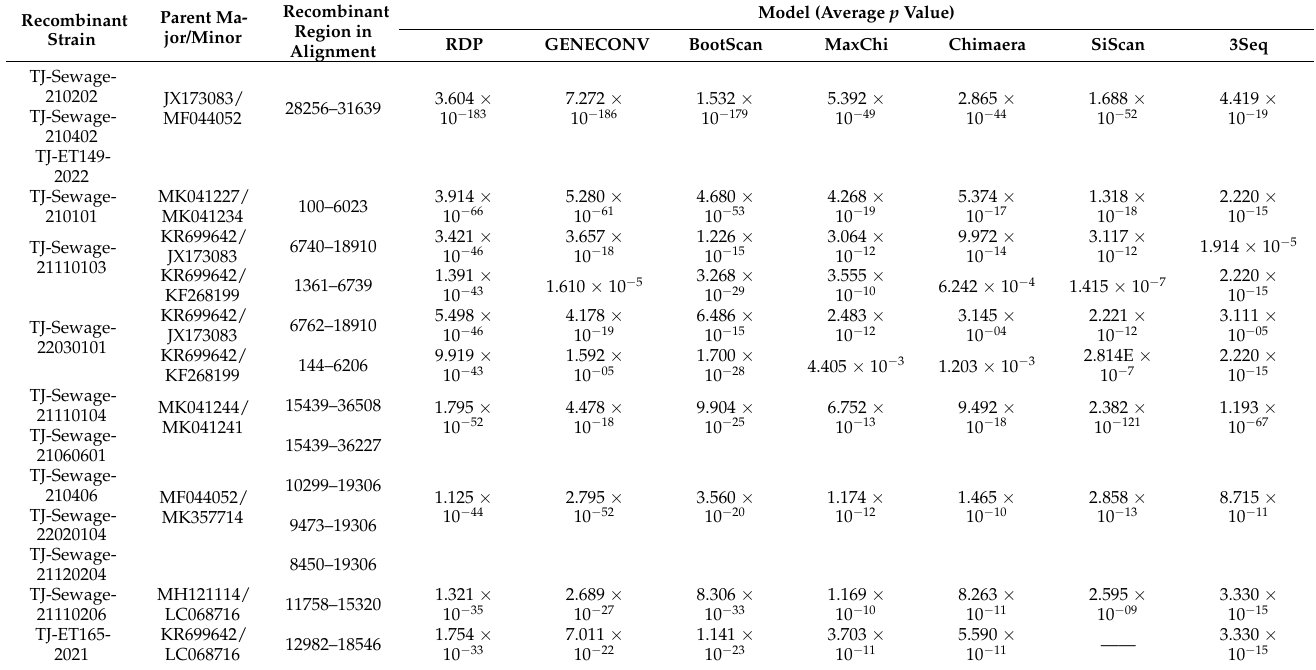
Table 4. Algorithms of the Recombination Detection Program (RDP) version 4 package used to predict the recombination events of 13 Tianjin